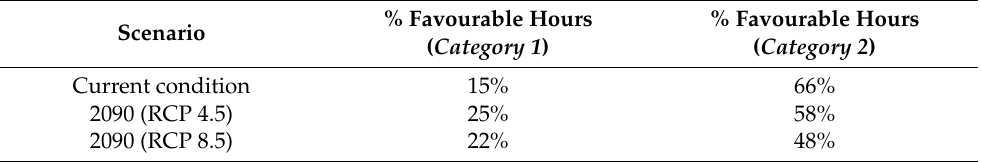
Table 9. Annual mycelium growth for the different climate scenarios examined.